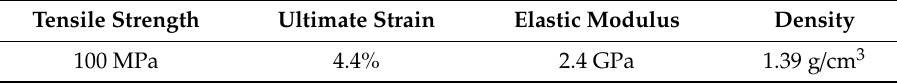
Figure 4. Specifications of the FRP flat coupon for tensile testing. Figure 2 . Specifications of the FRP flat coupon for tensile testing. Table 5. Mechanical properties of the polyester